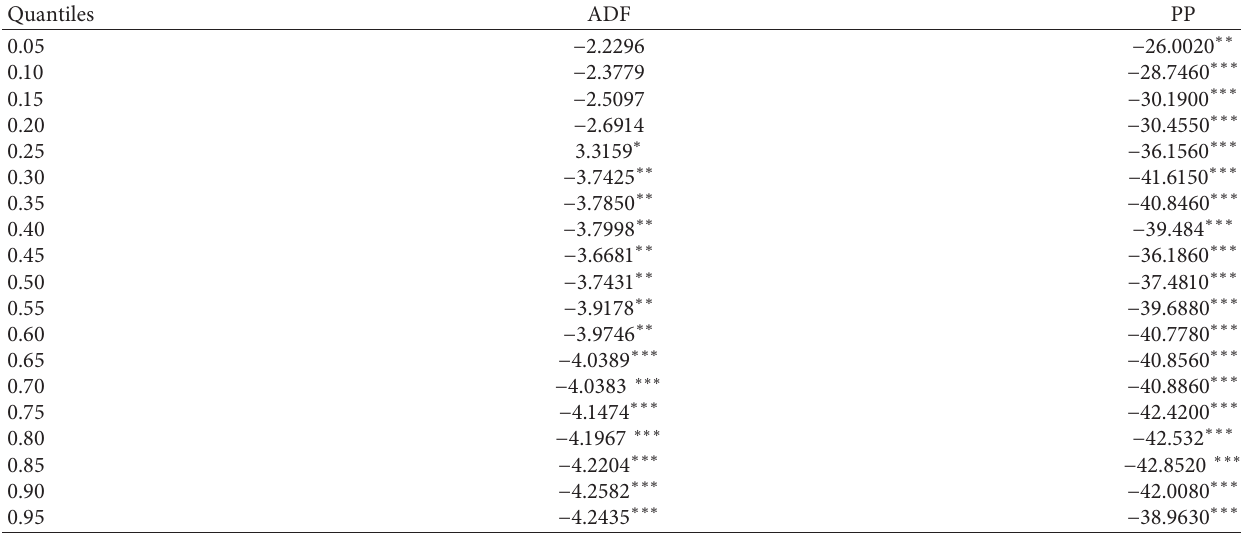
Table 9: Stationarity of quantile